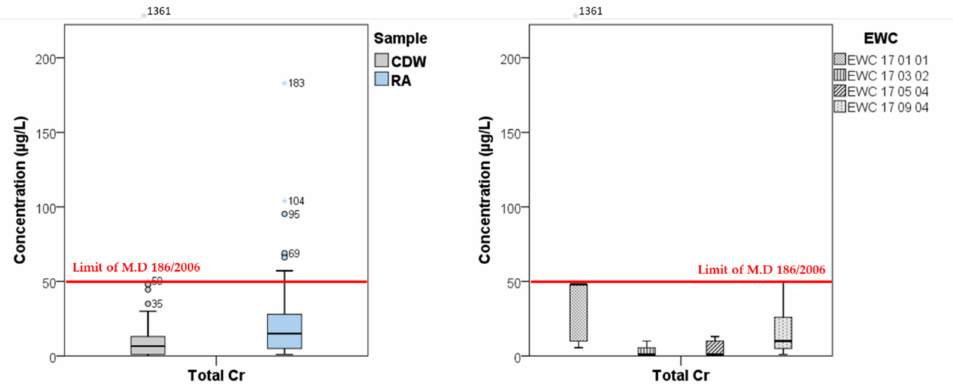
Figure 6. Total chromium release in CDWs and RAs ( left ) and EWC code responsible for the highest release ( right